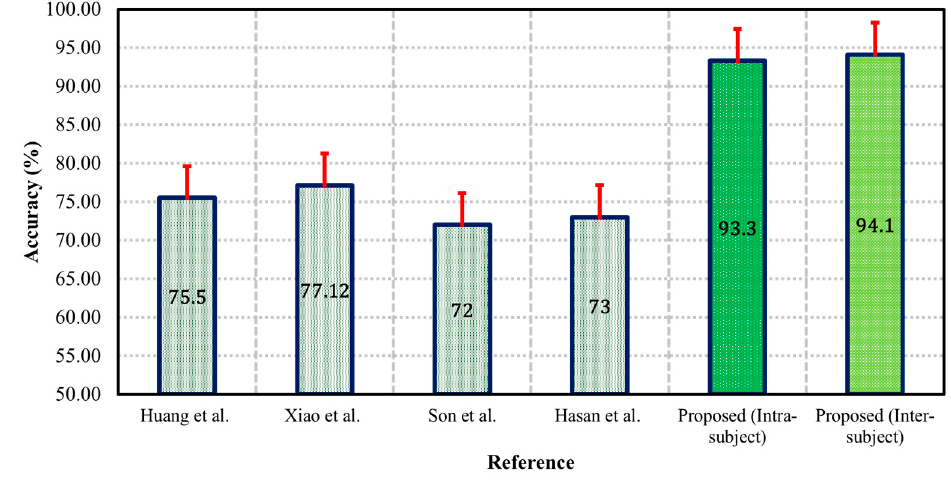
Figure 9. Comparison between previously published and proposed accuracy of the system.